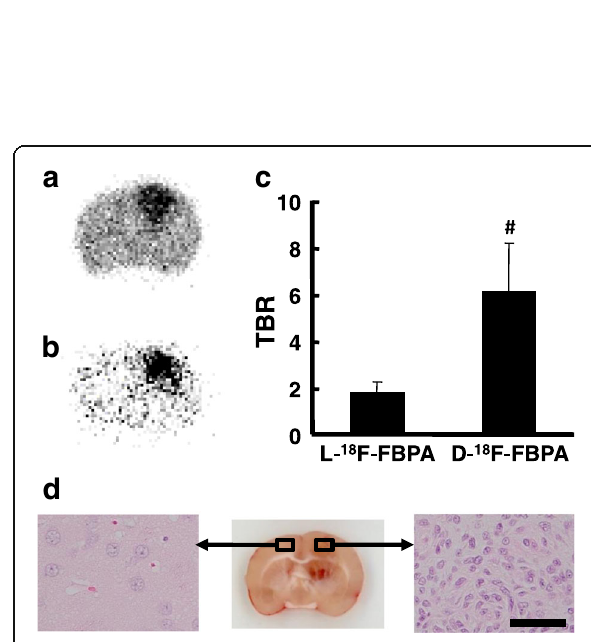
Fig. 5 Ex vivo autoradiography and histochemical imaging of C6 glioma-bearing rat brains. After PET imaging using L- ( a ) or D- 18 F-FBPA ( b ), rats were sacrificed under anesthesia, the brain was excised and sliced at a thickness of 2 mm, and the slices were then exposed to a phosphoimaging plate in order to calculate the target tumor (glioma) to non-target (normal) ratios of L- and D- 18 F-FBPA ( c ). # P <0.05 vs. L-isomer. The brain excised from another rat bearing C6 glioma was fixed in 4% neutral-buffered formalin; samples were embedded in paraffin, sliced at a thickness of 30 μ m, and stained with HE ( d